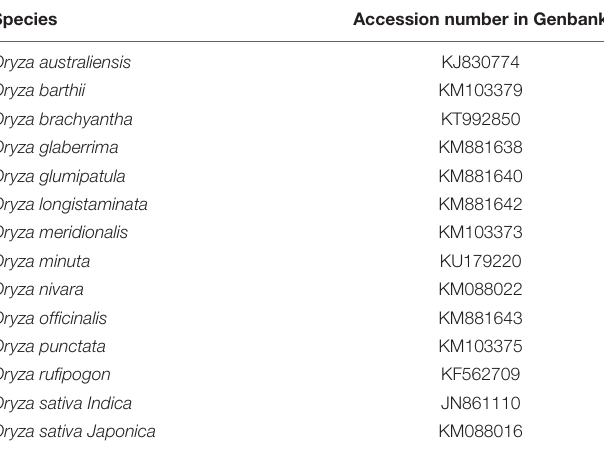
TABLE 1 | A list of the 14 taxa sampled from Genbank in this study.